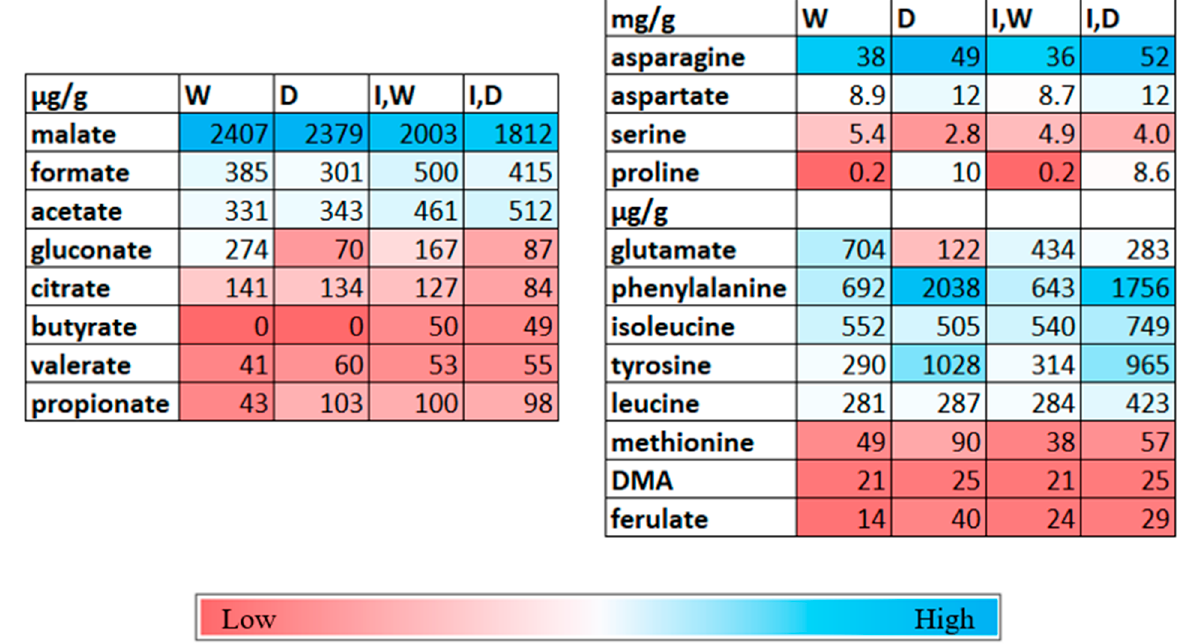
Figure 3. Representation of changes in specific metabolites in shoot extracts after wheat seedling growth under four conditions: non-inoculated watered (W), non-inoculated drought-stressed (D), inoculated with Pc O6 (I) and watered (I,W), and inoculated with Pc O6 and drought-stressed (I,D). The data shown are µg or mg levels of each metabolite/g dry mass of the shoots based on nine boxes for each treatment. Statistical data are provided in Supplementary Table S2. The heat map shows lower levels in red and higher levels in blue for each metabolite.